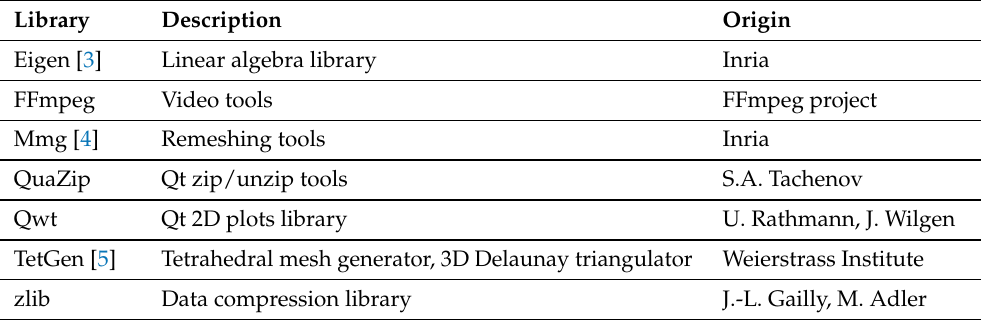
Table 2. External libraries used in MUSICardio plugins.